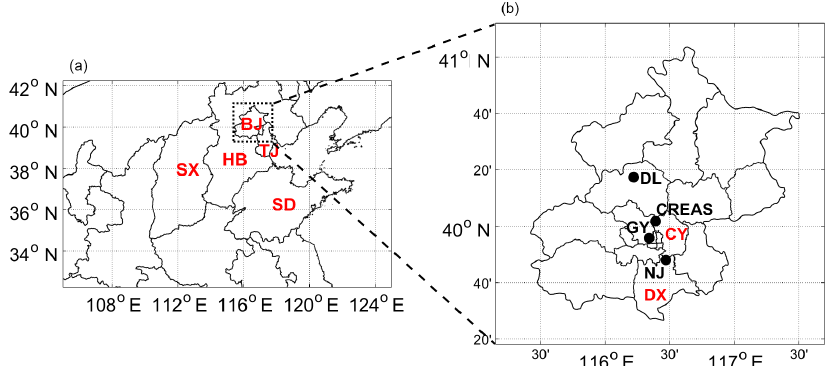
Figure 1. (a) Model domain and location of the cities of Beijing (BJ) and Tianjin (TJ) and the provinces of Hebei (HB), Shandong (SD), and Shanxi (SX); (b) locations of the Chinese Research Academy of Environmental Sciences (CRAES), Guanyuan (GY), the Dingling (DL), and Nanjiao (NJ) stations, and the districts of Daxing (DX) and Chaoyang